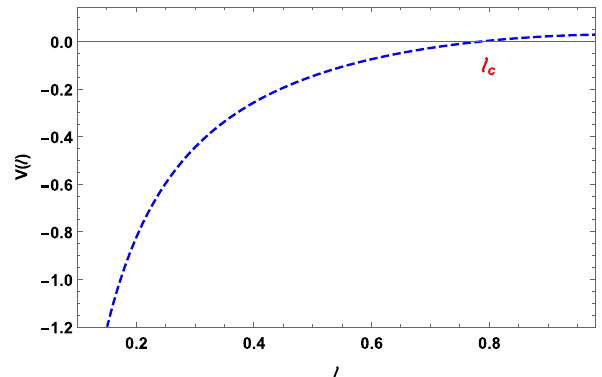
Fig. 1 The static potential of quark–antiquark pair in terms of l for T f = 0 . 3183 and ν =